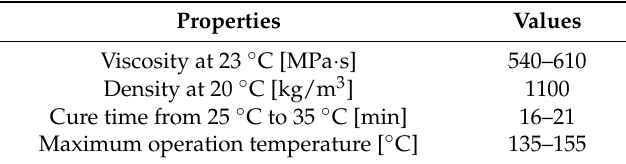
Table 2. Physical properties of Palatal P4-01 polyester resin.